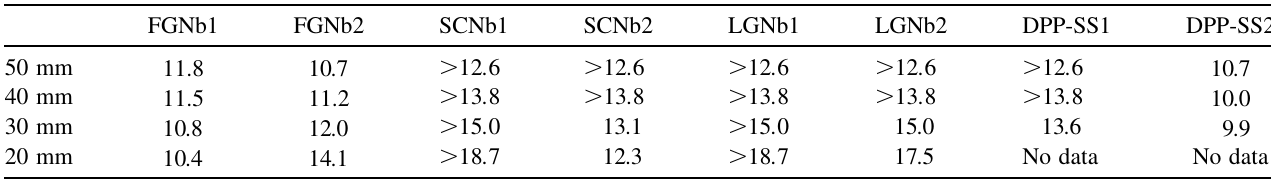
TABLE I. The field strength required to produce 100 pA of field emission, following krypton processing. For entries with ( > ) symbol, field emission current did not exceed 100 pA at 225 kV bias voltage, the maximum voltage available.